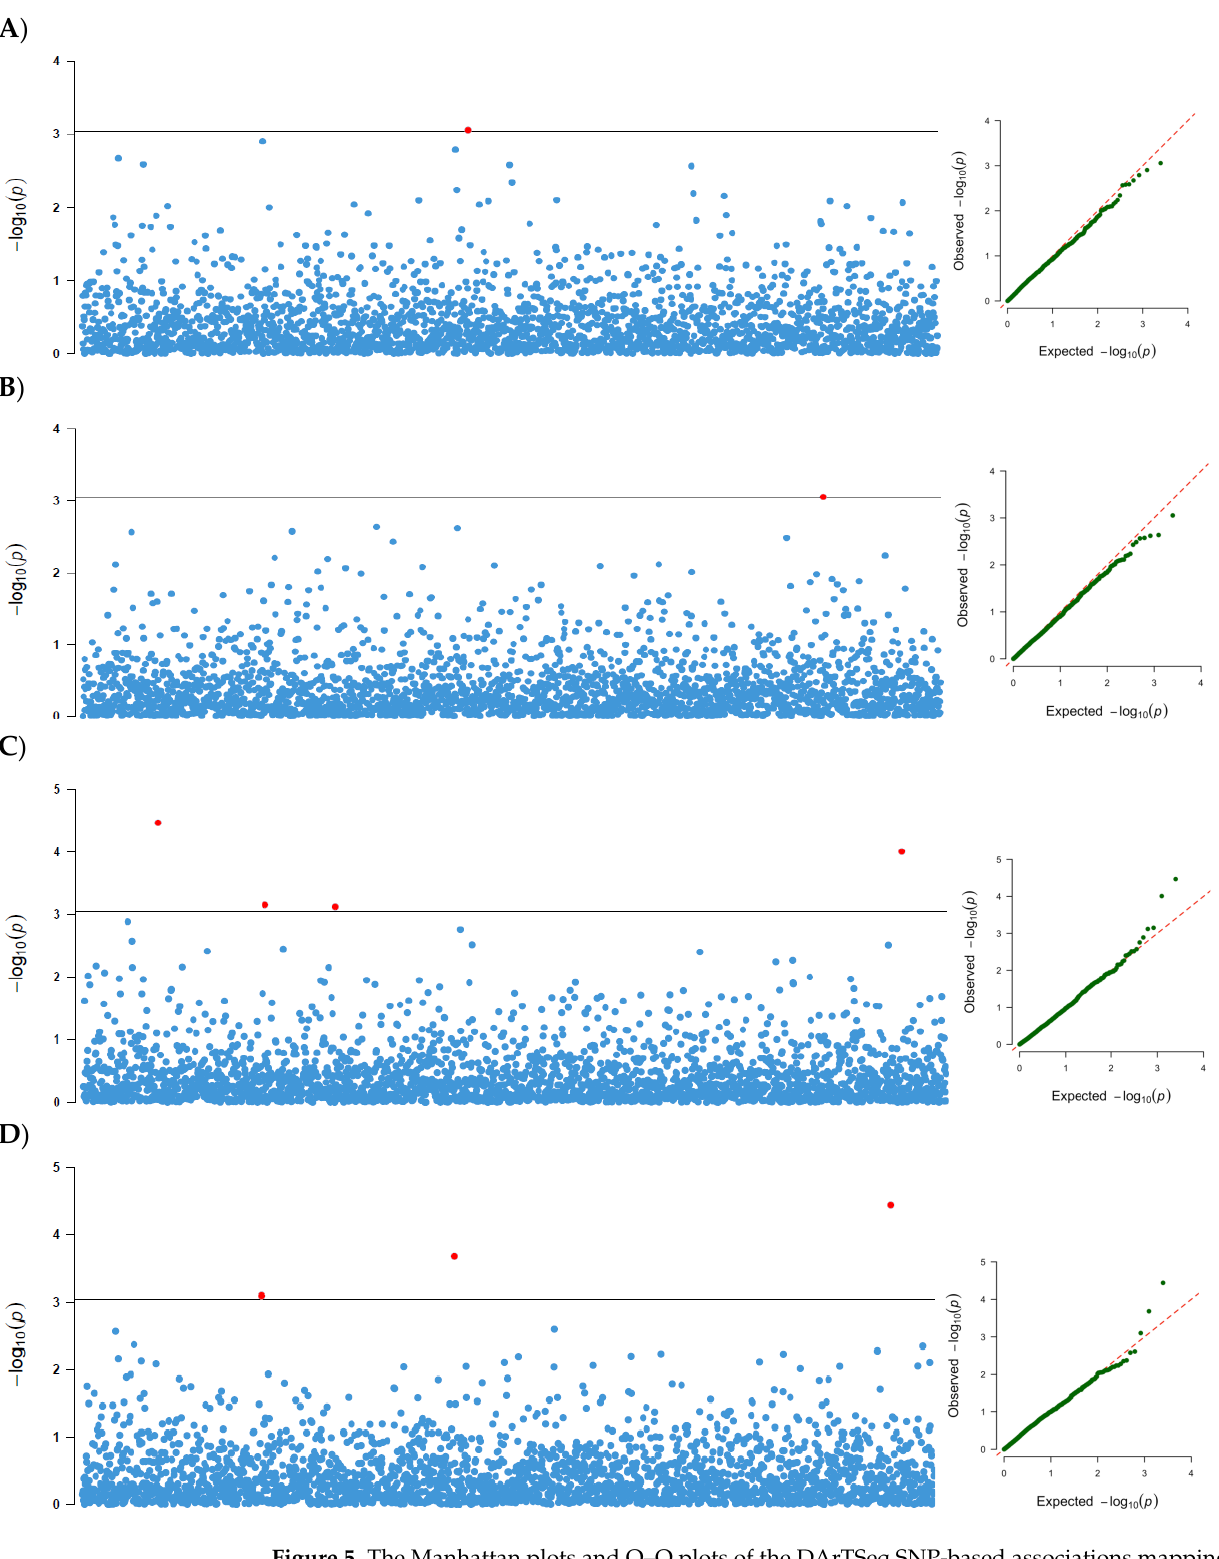
Figure 5. The Manhattan plots and Q – Q plots of the DArTSeq SNP-based associations mapping in the combined test environments analysis for: ( A ) hundred seeds weight (HSW), ( B ) seed length (SL), ( C ) seed thickness (ST), and ( D ) seed width (SW) using the MLM approach. Candidate gene analysis was performed by blasting trimmed nucleotide sequences (60–80 bps) of significant AYB SNPs in the combined location analysis on the